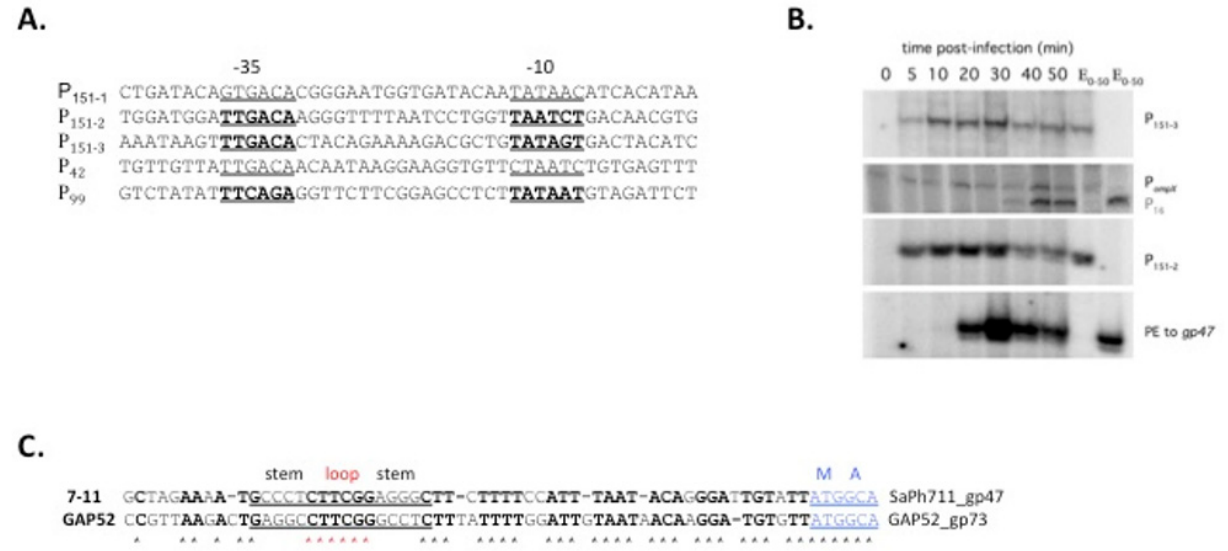
Figure 5. Kinetics of accumulation of σ 70 -dependent transcripts during 7-11 infection and identi- fication of a potential regulatory hairpin in front of gene 47 : ( A ) Sequences of all predicted σ 70 - promoters of bacteriophage 7-11 (from NC_015938 file) are shown; putative − 35 and − 10 promoter consensus elements are underlined/indicated by bold typeface. ( B ) Results of multiplex primer ex- tension analysis with total RNA extracted from phage-infected cells collected at various time points postinfection, using primers designed to reveal transcription from bioinformatically predicted σ 70 - promoters shown in panel ( A ), are shown. Only promoters in front of gene 151 (151-2 and 151-3) were validated. A primer annealing downstream of late promoter P 16 was used as a control to indi- cate late gene expression. A primer annealing to Salmonella Newport gene ompX mRNA was used to follow the fate of a host transcript. Results of reaction of extension of a primer annealing down- stream of gene 47 are shown at the bottom. On the right, products of extension reactions with indi- vidual primers on RNA sample prepared by mixing RNA samples from each time point (E 0–50 ) are shown (a control to establish the identity of primer extension products). The reaction products were separated in 6% denaturing polyacrylamide gel and visualized using PhosphorImager. ( C ) Identifi- cation of type (X) 5 GTTCGG(Y) 5 hairpins in the intergenic region in front of SaPh711_gp47 and phage GAP52 σ factor gp73 genes. Conserved nucleotides are shown in boldface, protein-coding sequence is shown in blue and loop of the hairpin is shown in red. 4. Discussion In this work, we report analysis of temporal gene expression regulation of phiEco32- like bacteriophage 7-11. Unlike phiEco32 and most other lytic phages, 7-11 genes belong to just two expression classes: early and late. Early transcription initiates from two strong σ 70 -dependent promoters located at the right end of the genome and proceeds leftward, resulting in long polycistronic transcripts covering almost half of the genome. The first late promoter is located upstream of gene 69. Gene 47 , coding for the 7-11 σ factor respon- sible for late transcription, is presumably transcribed, at least initially, by RNAP mole- cules that initiate transcription from early σ 70 -dependent promoters. Since 47 is located deep in the leftward transcribed cluster of late phage genes, there should be some tran- scription read-through from early promoters to allow late transcription to occur. It is highly likely that 7-11 employs some strategy to antiterminate transcription that remains to be defined. The amount of gene 47 transcripts can subsequently strongly increase through a positive feedback loop due to activity of late P 48 promoter, thus orchestrating a switch from early to late phage transcription. Robust production of SaPh711_gp47 in amounts necessary to compete with σ 70 may be further stimulated by a sequence in the intergenic region between genes 47 and 48 that can form a stem-loop structure with a GTTCGG loop (Figure 5C). An identical sequence is found in the corresponding place of GAP45, a 7-11 relative that has only 10% identity with 7-11 genome-wide. Similar sequences (X) 2-8 CUUCGG(Y) 2-8 (where X is complement